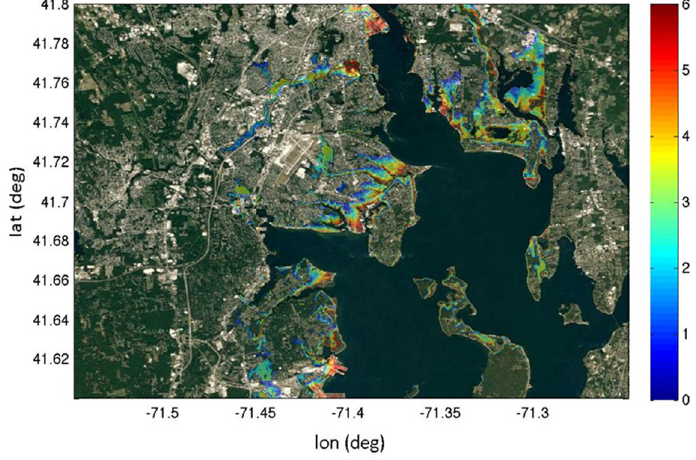
Figure A6. Total water depth (m) (inundation plus controlling wave height) for Warwick, RI, 100 year event, plus 2.1 m (7 feet) of SLR.